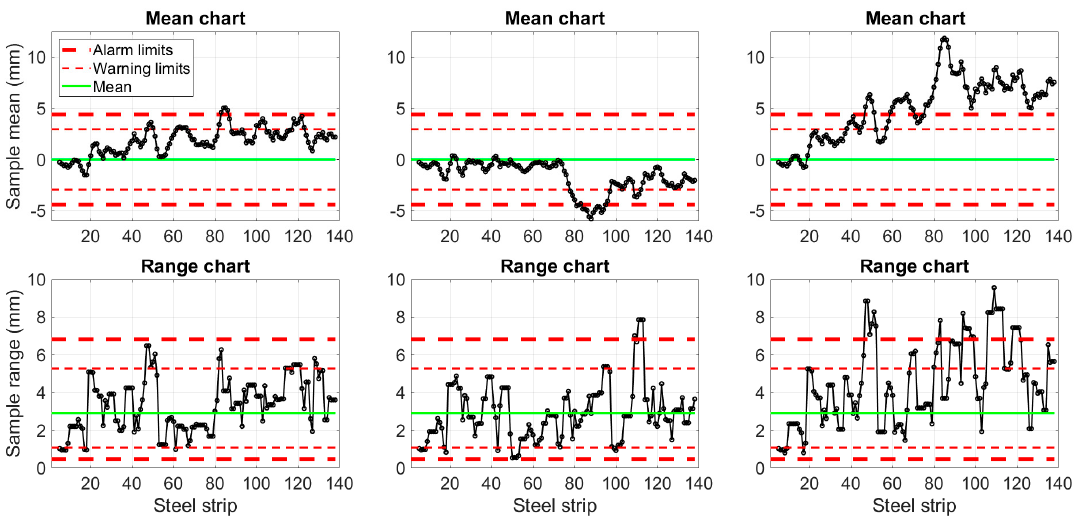
Figure 15. Different anomalies in the explanatory variable x 1 of thickness model.